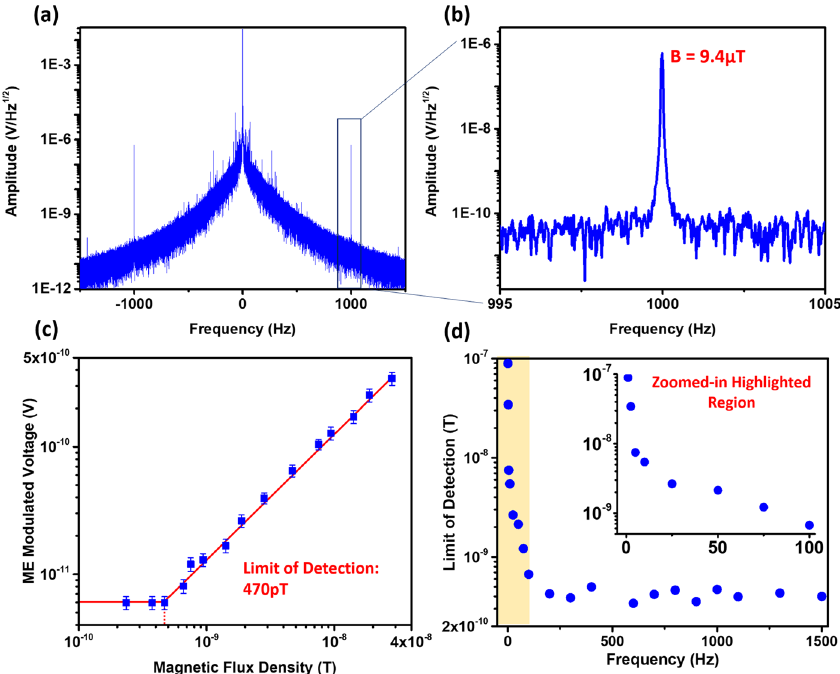
Fig. 5 ME antenna magnetic sensing measurement results. a Power spectrum of the re fl ected signal from the ME antenna after demodulation and low- pass fi ltering. The plot shows both modulation components of ω c (cid:4) ω m and ω c þ ω m . The carrier signal is located at the center and has an amplitude of p . The noise fi gure decreases signi fi cantly with increasing frequency — which is because of the low-pass fi ltering and the 1/f electronics noise 2 : 9 ´ 10 (cid:4) 2 V ffiffiffiffi Hz reduction — improving the SNR of the sensor at higher frequencies; b The zoomed-in plot shows the modulation signal at 1 kHz with an amplitude of p , which corresponds to an external magnetic fi eld of H m ¼ 9 : 4 μ T ; c ME modulated voltage versus amplitude of the external magnetic fi eld H m 6 : 2 ´ 10 (cid:4) 7 V ffiffiffiffi Hz at 1 kHz frequency, showing a LOD of 470 pT; d LOD of ME antenna versus frequency of external alternating magnetic fi eld H m . The LOD of the sensors improves with increasing the frequency because 1 = f electronics noise is strong at very low frequencies. At frequencies higher than 100 Hz , both noise and ME modulation voltage decrease with almost the same rate, which is why the LOD, or i.e. the SNR, becomes almost fl at. The inset plot shows the zoomed- in highlighted region (frequencies lower than 100